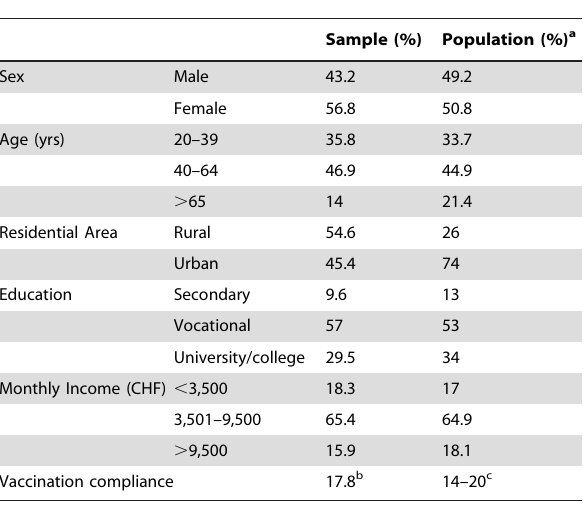
Table 1. Sample Characteristics Compared to Swiss